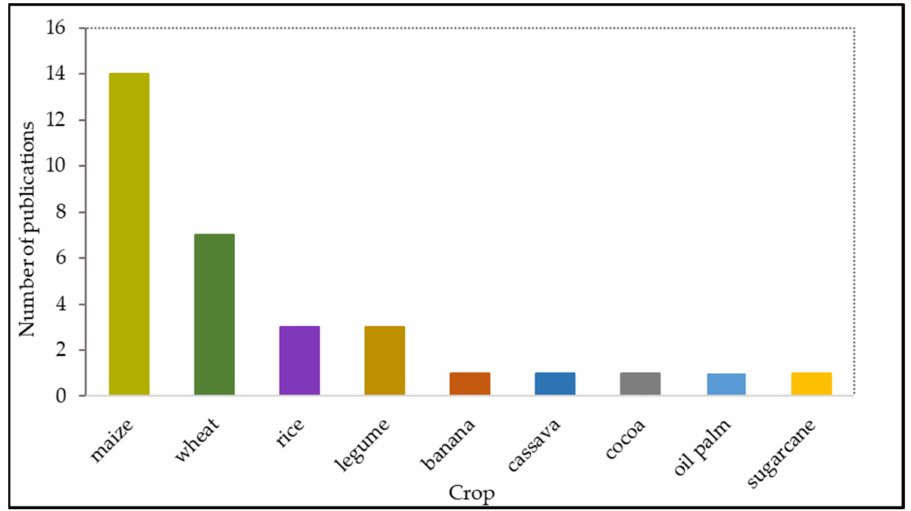
Figure 4. Histogram showing the number of publications in Africa between 1998 and 2020 with regards to the used crops with yield